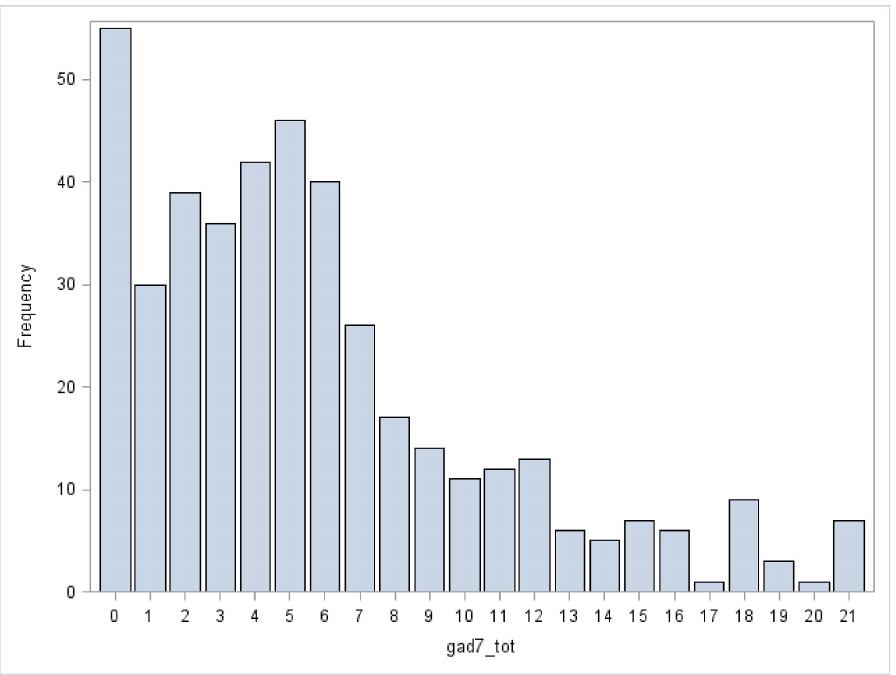
Fig 2. Distribution of GAD-7 scores in study